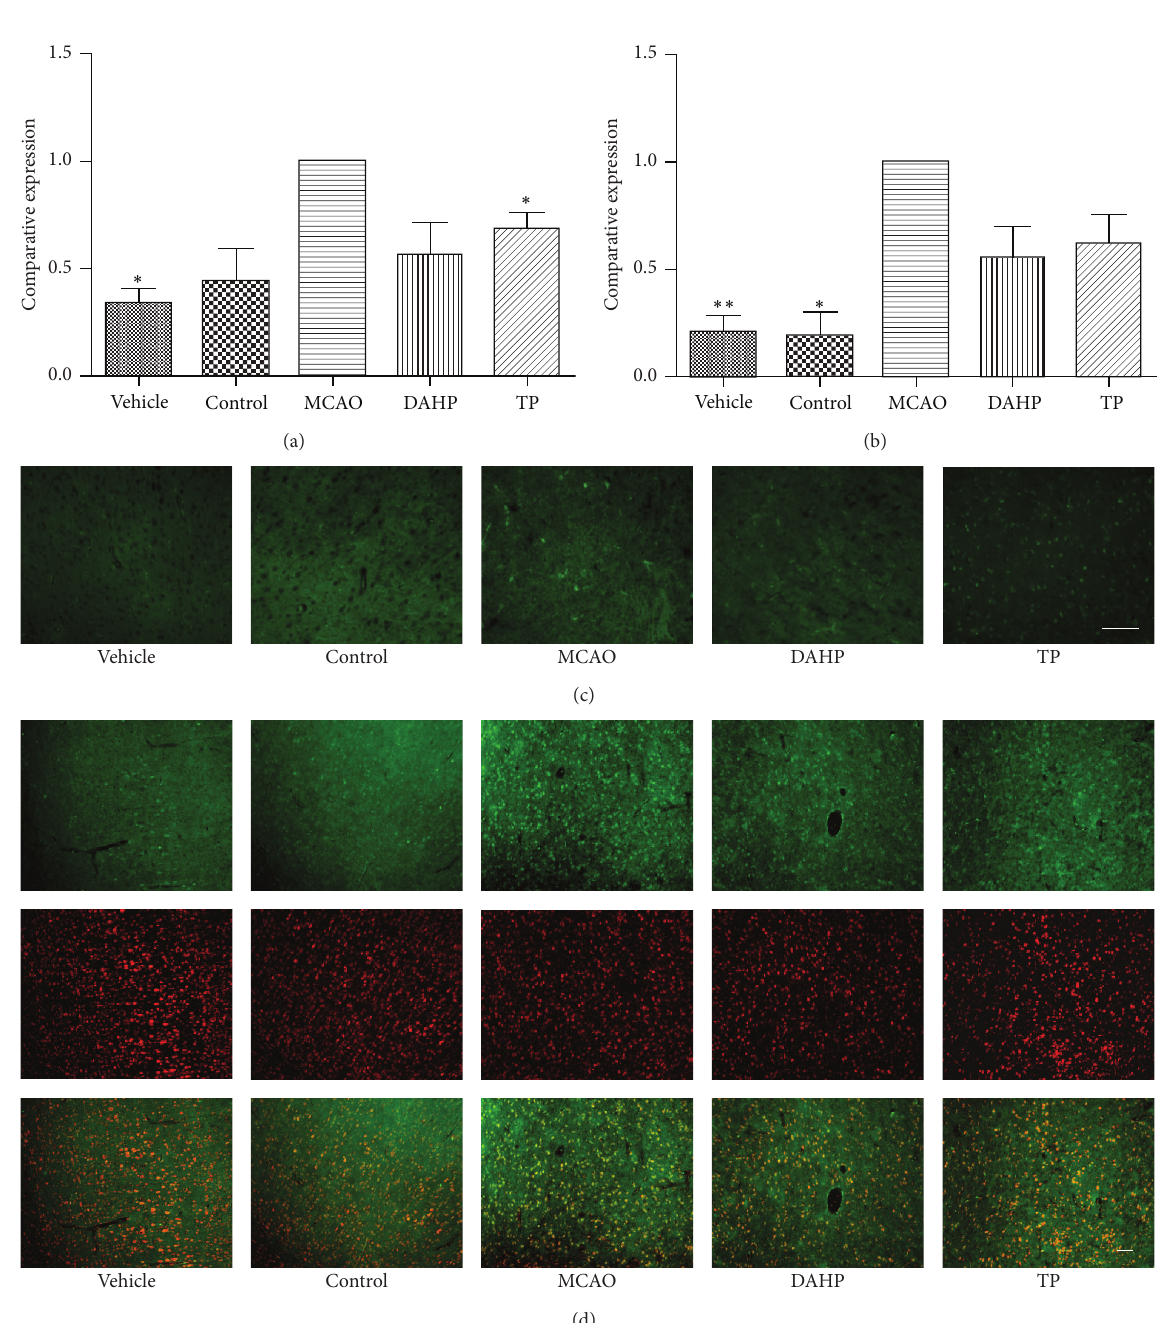
Figure 2: Apoptosis level detected by immunofluorescent labeling and TUNEL staining in each group. It can be seen from the images that both the expression of caspase-3 and TUNEL and, therefore, apoptosis, decrease in DAHP and TP. (a) The histograms show positive cells detected by TUNEL staining in each group. Values are means ± SEMs. ∗ 𝑃 < 0.05 ; ∗∗ 𝑃 < 0.001 ; ∗∗∗ 𝑃 < 0.0001 ; n.s.: no significance. (b) The histograms showed expression of caspase-3 in each group. Values are the means ± SEMs. ∗ 𝑃 < 0.05 ; ∗∗ 𝑃 < 0.001 ; ∗∗∗ 𝑃 < 0.0001 ; n.s.: no significance. (c) Compared with vehicle and control, the image shows more positive cells presented in MCAO, DAHP, and TP. Also MCAO owns the largest number of positive cells. (d) The images of expression levels of caspase-3 show similar change trends among each group in which both DAHP and TP decrease apoptosis. Bar = 100 𝜇